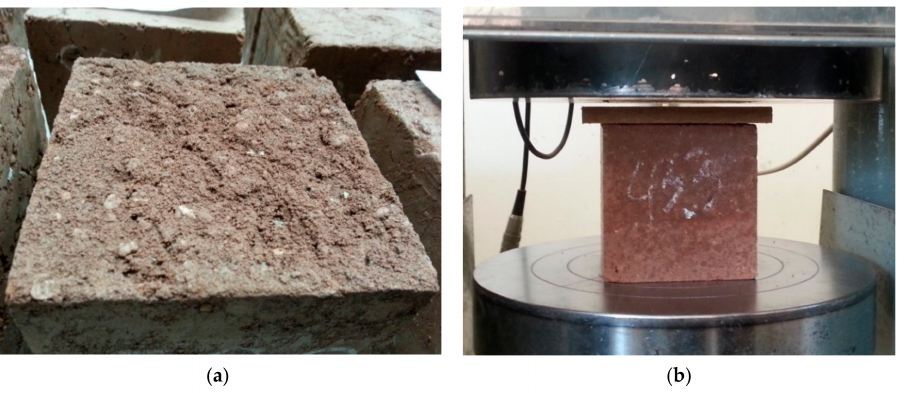
Figure 2. ( a ) Rough top surface of the rammed earth sample, ( b ) the sample during compressive strength test—a soft fiberboard shim was placed on the upper surface of the sample.